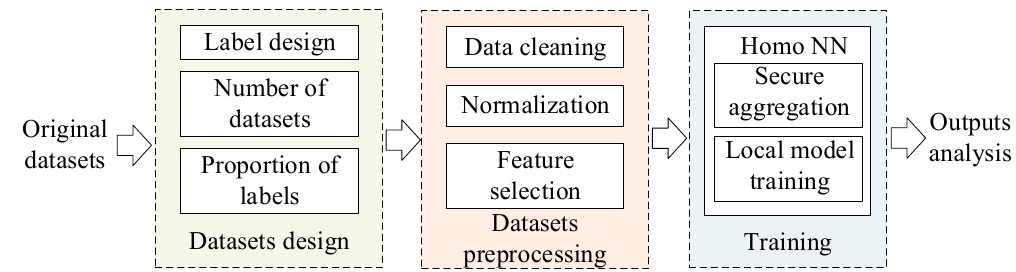
Figure 2. Training flow chart of federated learning module.